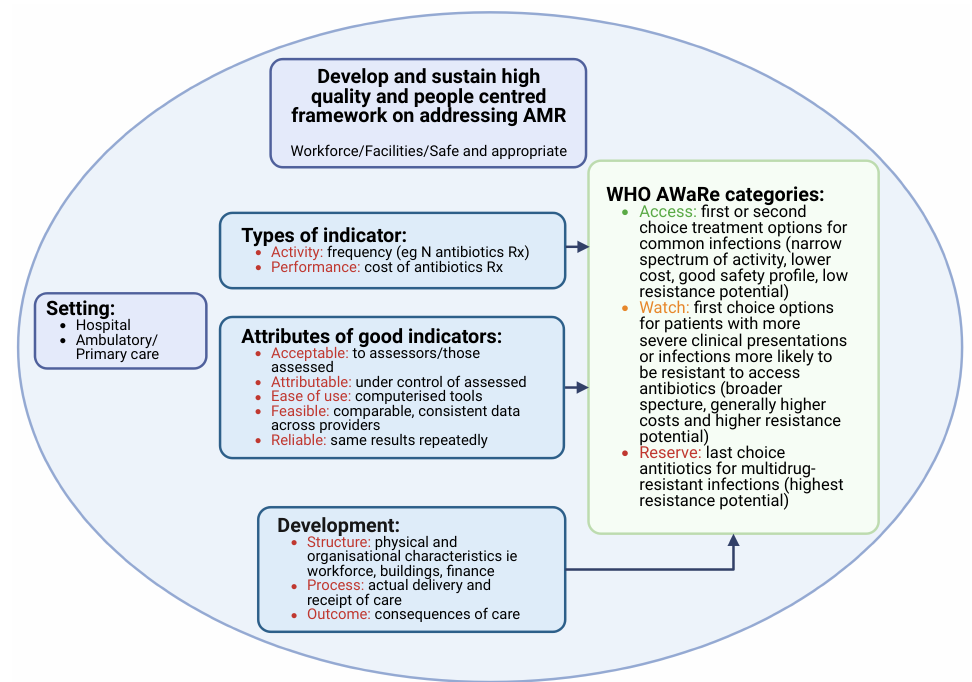
Figure 1. Key principles for indicator development for antimicrobials across Africa (adapted from [56,124–127]). NB: Created via Biorender (https://biorender.com/) with permission granted to Catrin Moore (accessed on 14 November